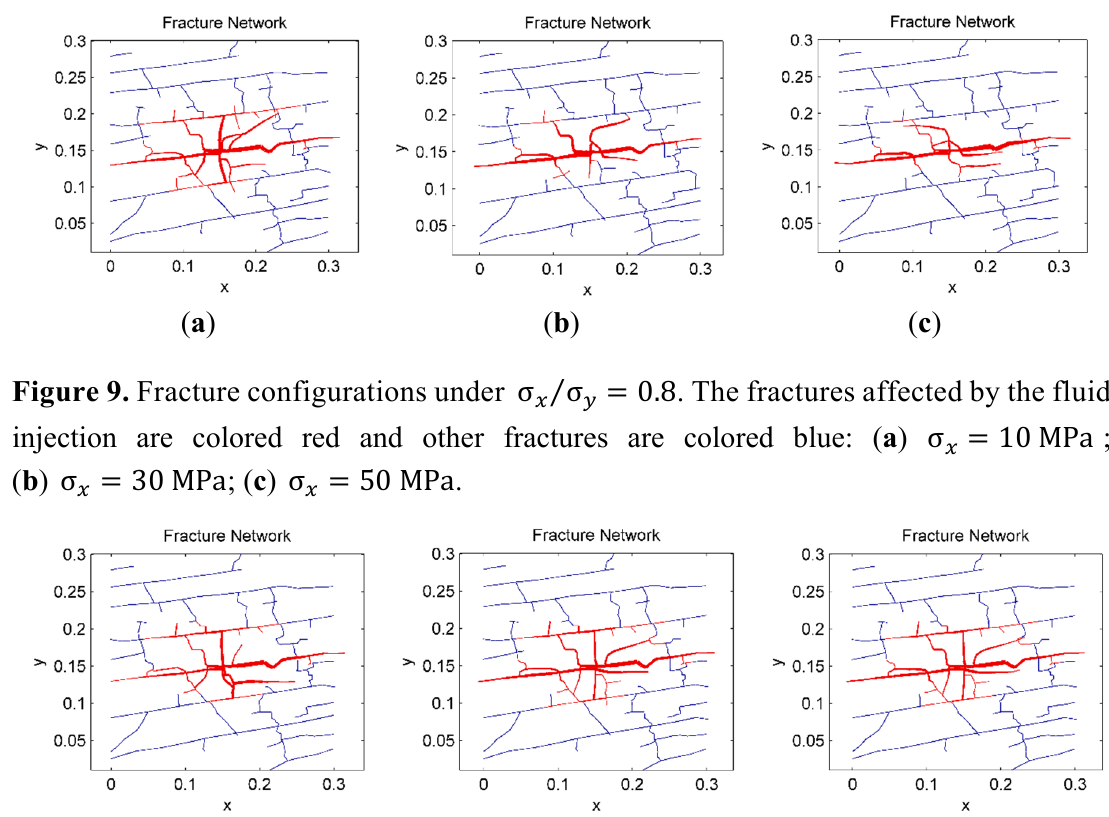
(cid:3398) σ (cid:3404) 4 MPa . The fractures affected by (cid:3051) (cid:3052)